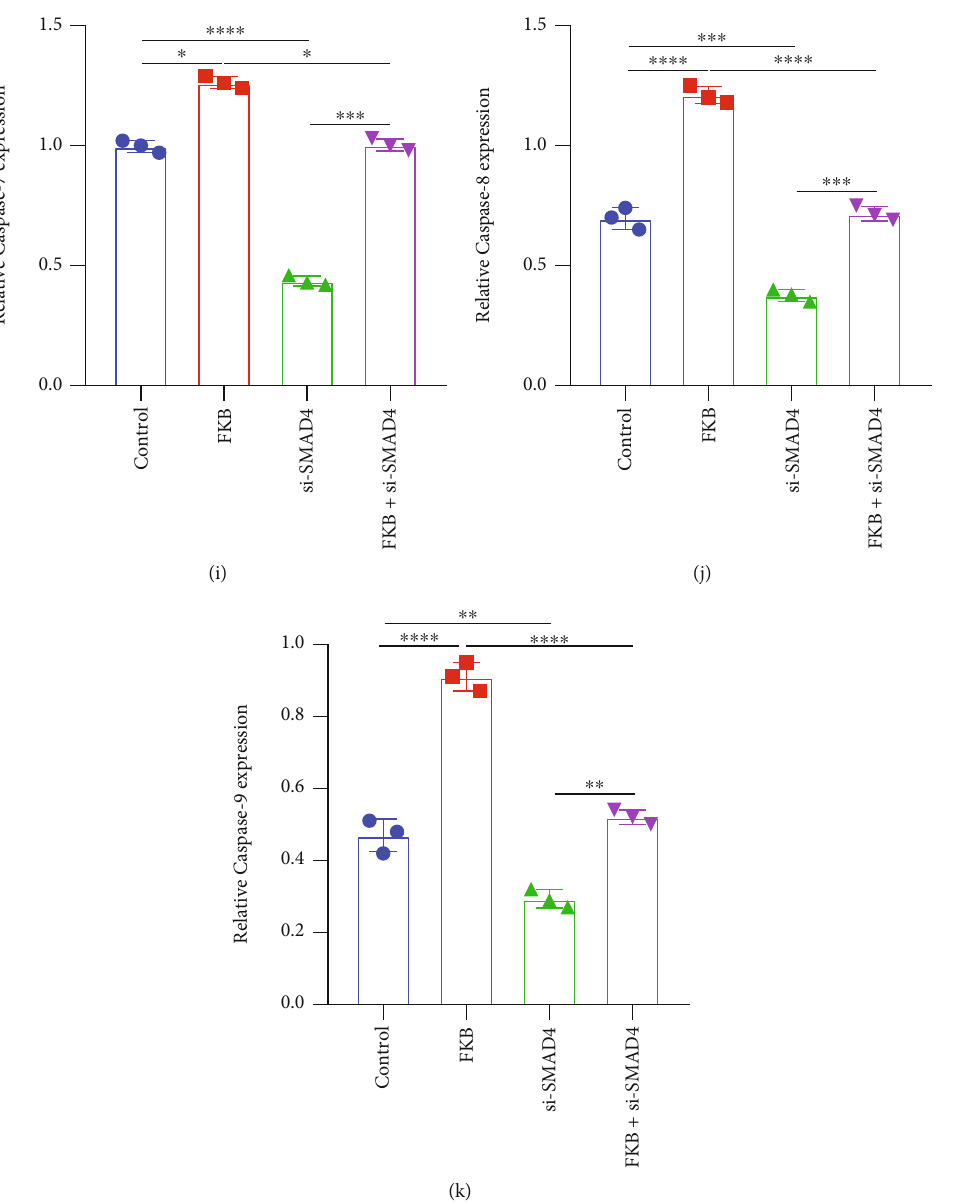
Figure 5: FKB suppresses growth and accelerates apoptosis of gastric cancer cells partly through SMAD4. (a) Cell growth curve for SGC- 7901 cells after treatment with FKB and/or si-SMAD4. (b, c) Apoptosis of SGC-7901 cells was investigated when transfection with FKB and/ or si-SMAD4 utilizing Annexin V-FITC/PI test. (d) Representative images of western blot. (e) Bax, (f) Bcl-2, (g) Bax/Bcl-2, (h) caspase-3, (i) caspase-7, (j) caspase-8, and (k) caspase-9 expression was quanti fi ed in SGC-7901 cells transfected with FKB and/or si-SMAD4. ∗ p < 0 : 05 ; ∗∗ p < 0 : 01 ; ∗∗∗ p < 0 : 001 ; ∗∗∗∗ p < 0 : 0001